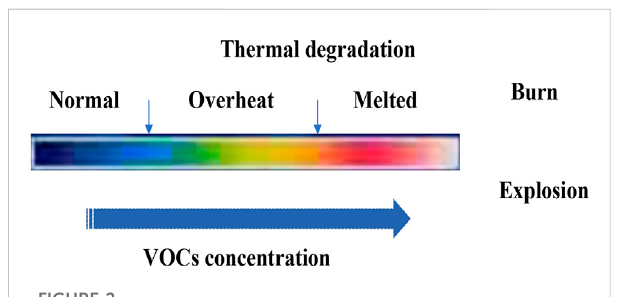
FIGURE 2 Thermal degradation process of the insulation